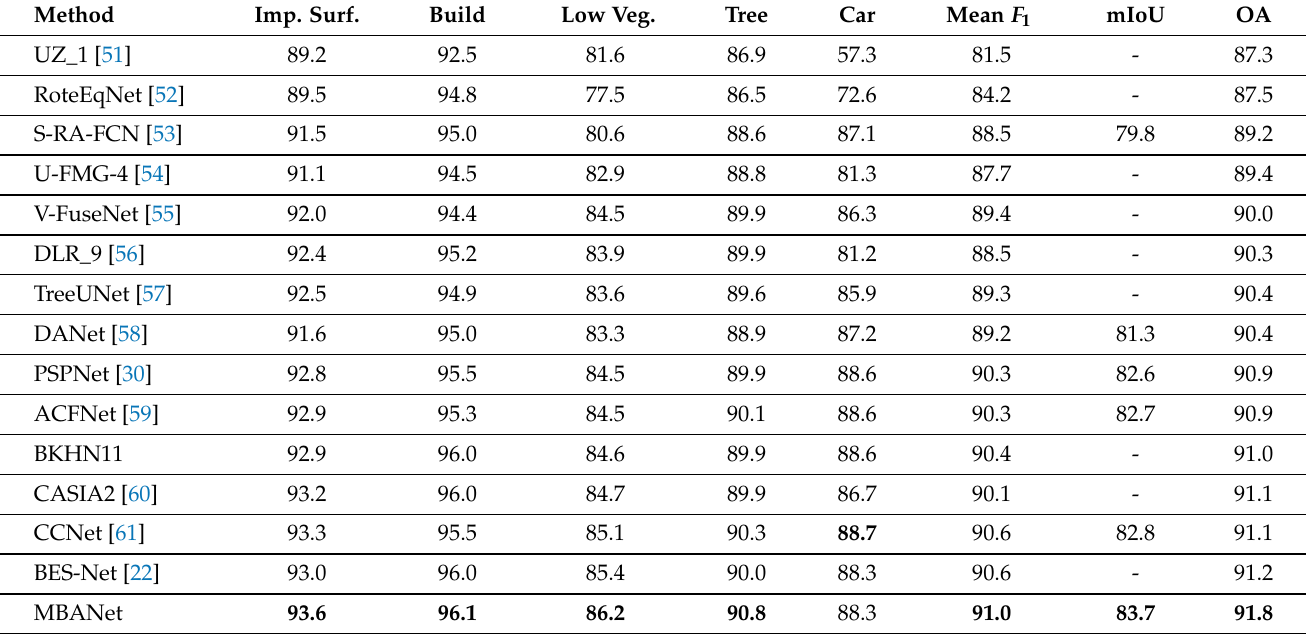
Table 12. Comparisons with SOTA methods on Vaihingen dataset.